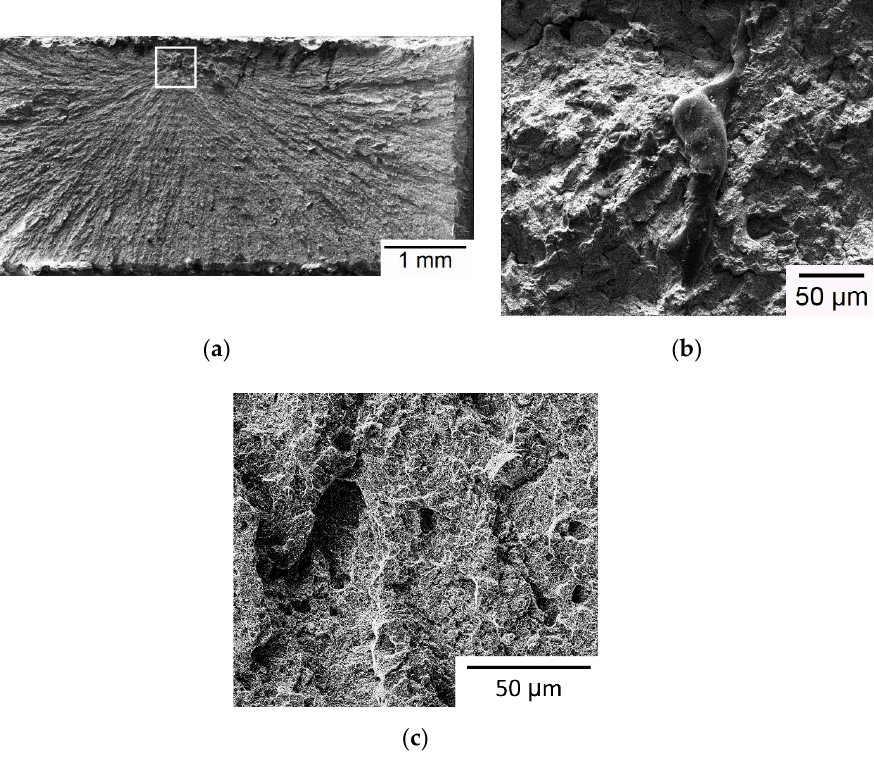
Figure 8. SEM micrographs of a Group C specimen: ( a ) Overview of fracture surface; ( b ) high-magnification view of the outlined fracture origin zone in ( a ); ( c ) high-magnification view of a region away from the fracture origin.